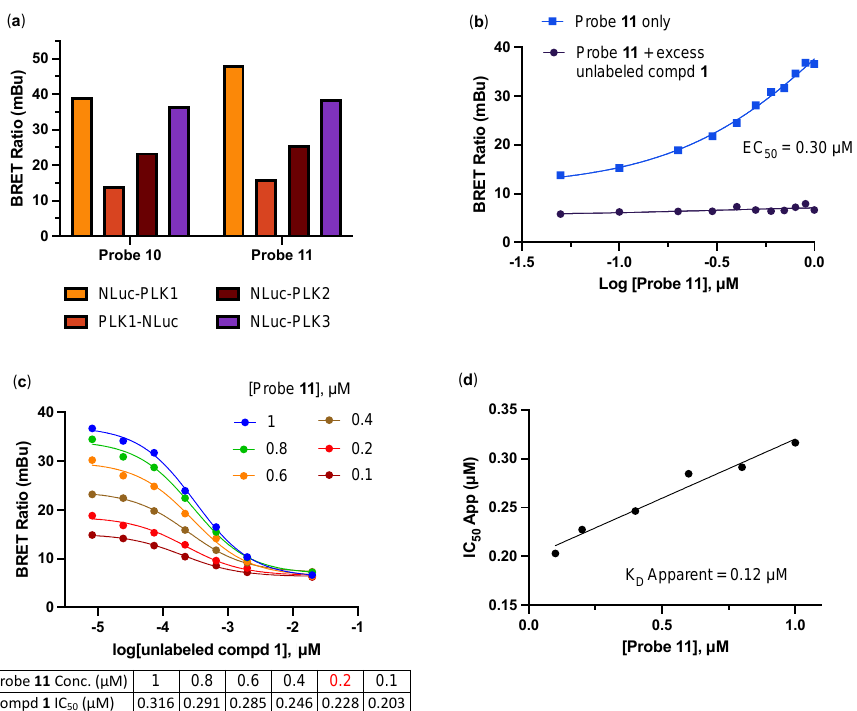
Figure 2. (a) BRET ratios observed with 1 µM of probes 10 and 11 on the PLK1, PLK2, and PLK3 NLuc fusion proteins. (b) Apparent affinity of intracellular NanoBRET energy transfer probe 11 for NLuc-PLK1 fusion protein in the adherent (ADH) format. (c) Optimization of NanoBRET transfer probe 11 concentration for the NLuc-PLK1 fusion protein in the ADH format. (d) Quantitative analysis of BRET using the Cheng – Prusoff relationship for PLK1 in live HEK293 cells with NanoBRET energy transfer probe 11 . The apparent K D value for compound 1 was determined from the y-intercept via linear regression. All data are an average of two technical replicates 15%.